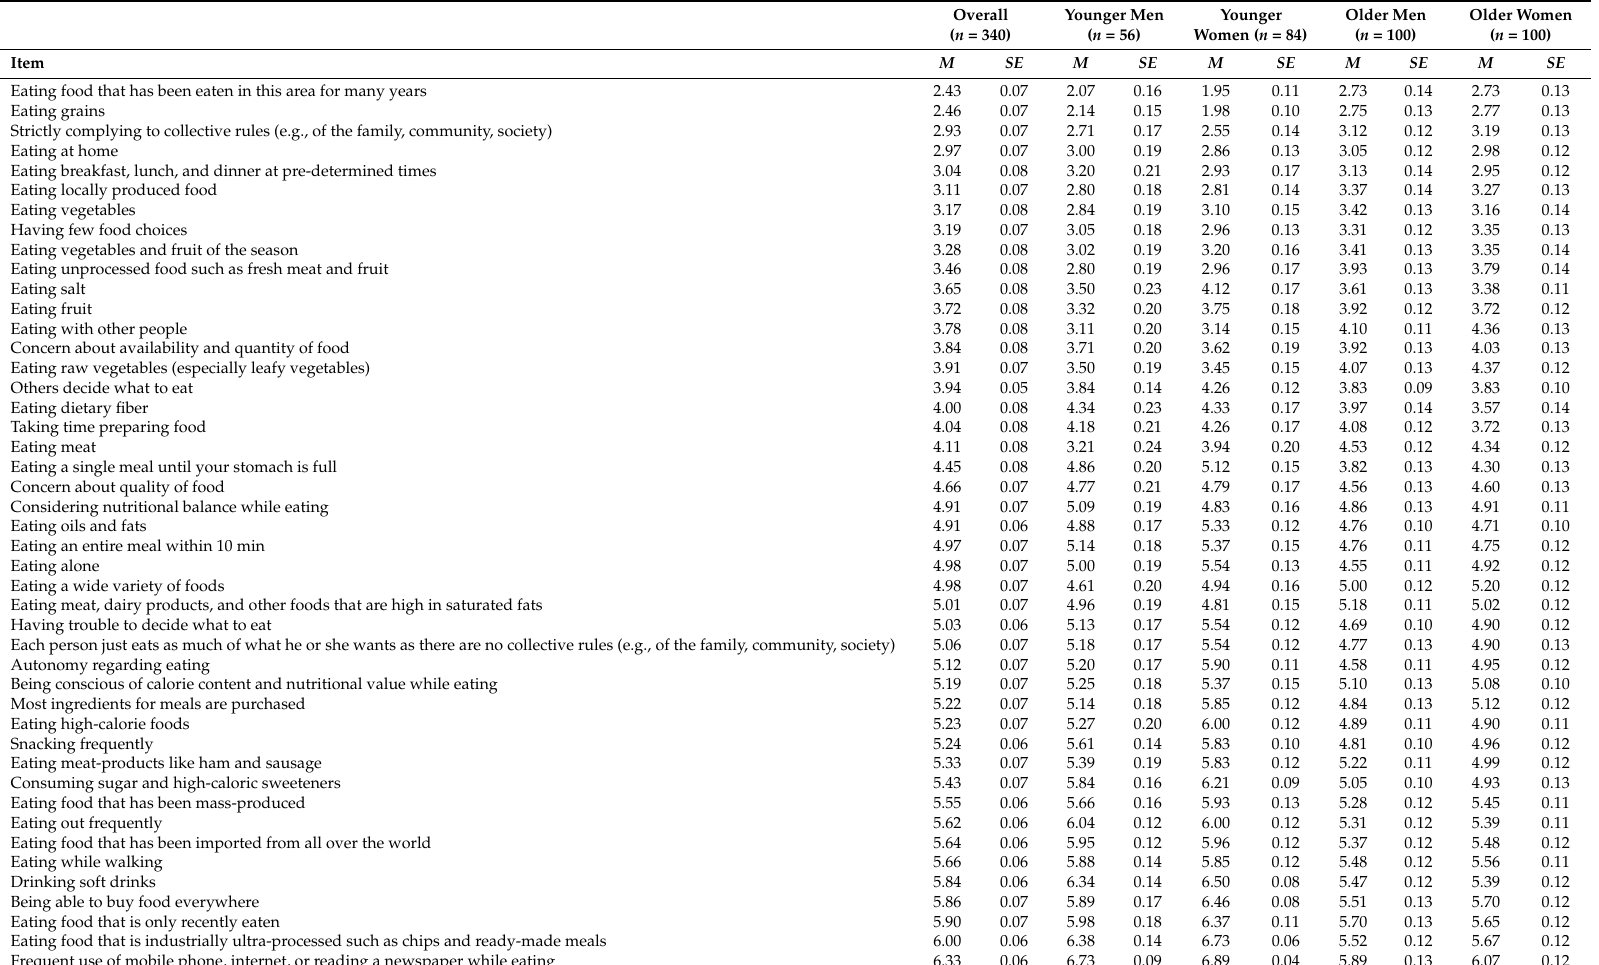
Table A1. Items, means ( M ) and standard errors ( SE ) for the total sample and the four